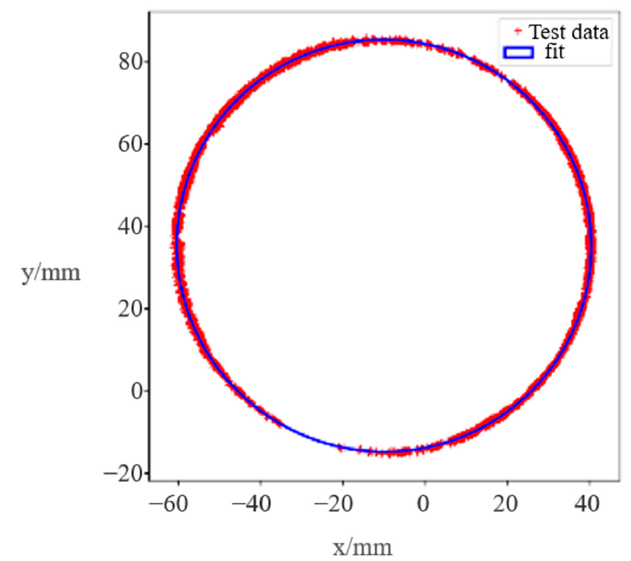
Figure 13. Ellipse fitting result graph.